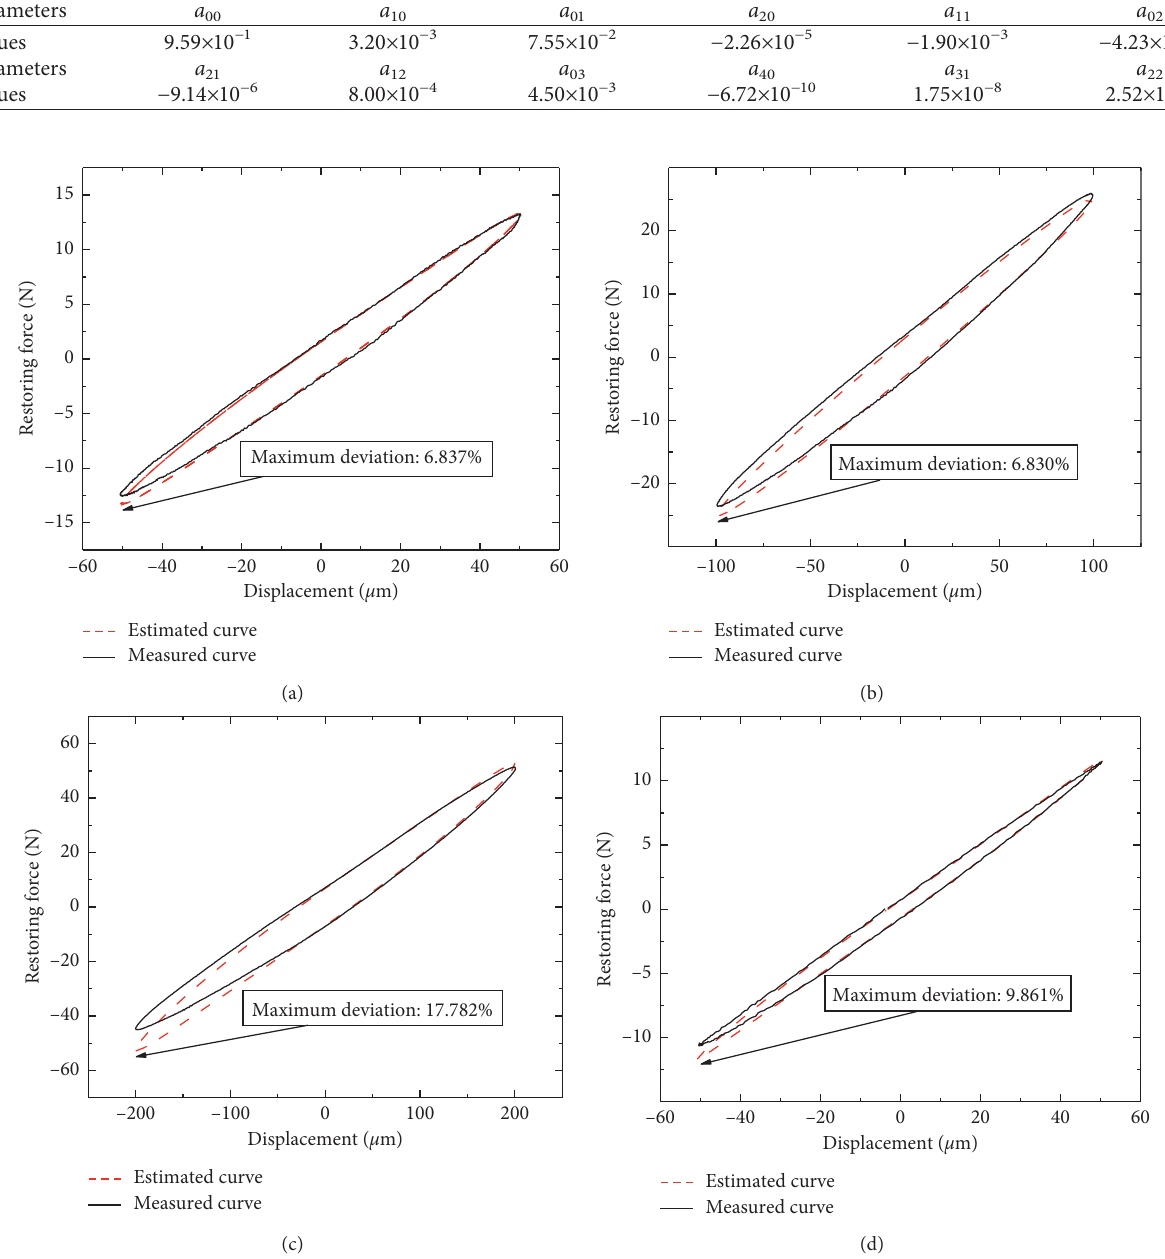
Figure 14: Comparison of estimated and measured hysteresis loops. (a) A � 50 μ m, f � 2Hz. (b) A � 100 μ m, f � 2Hz. (c) A � 200 μ m, f � 2Hz. (d) A � 50 μ m, f �